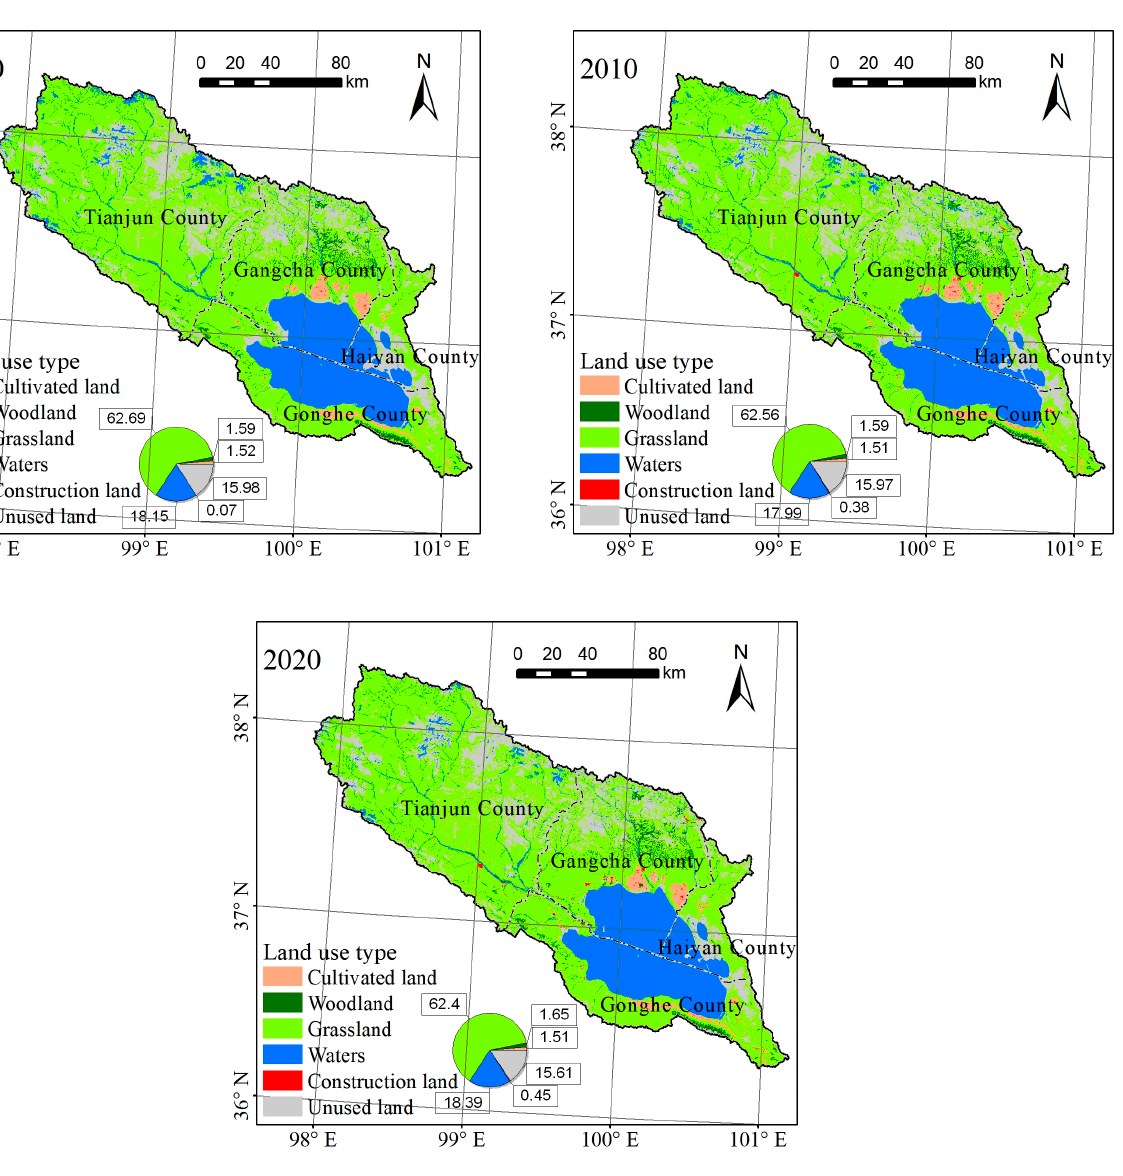
Figure 2. Spatial distribution of the land use/land cover (LULC) types in Qinghai Lake Basin from 2000 to 2020.